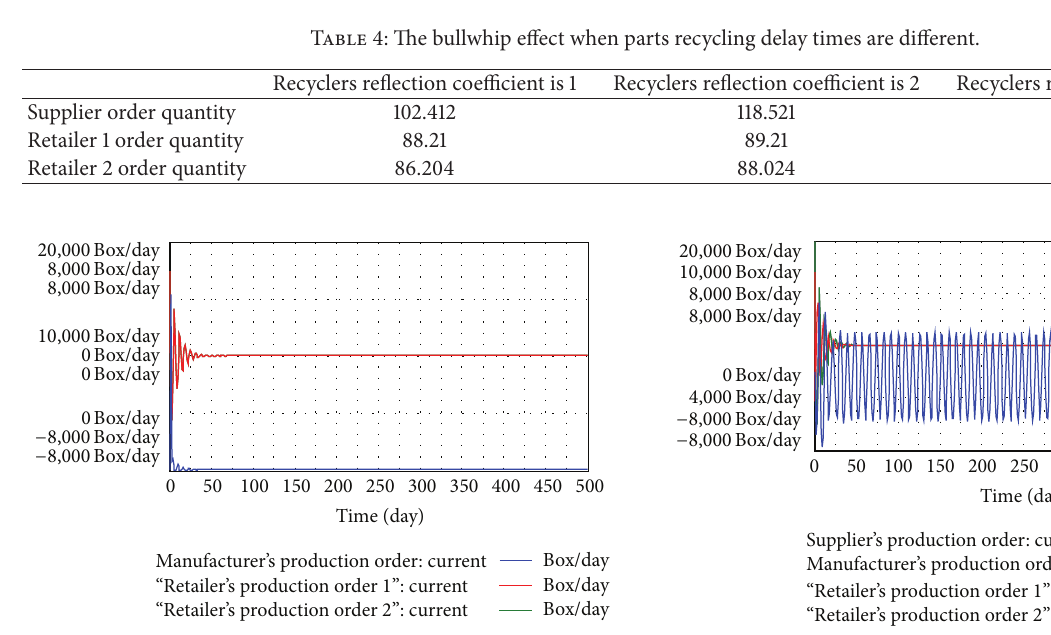
Figure 14: Changes of the order quantity of each member when parts recycling delay time is